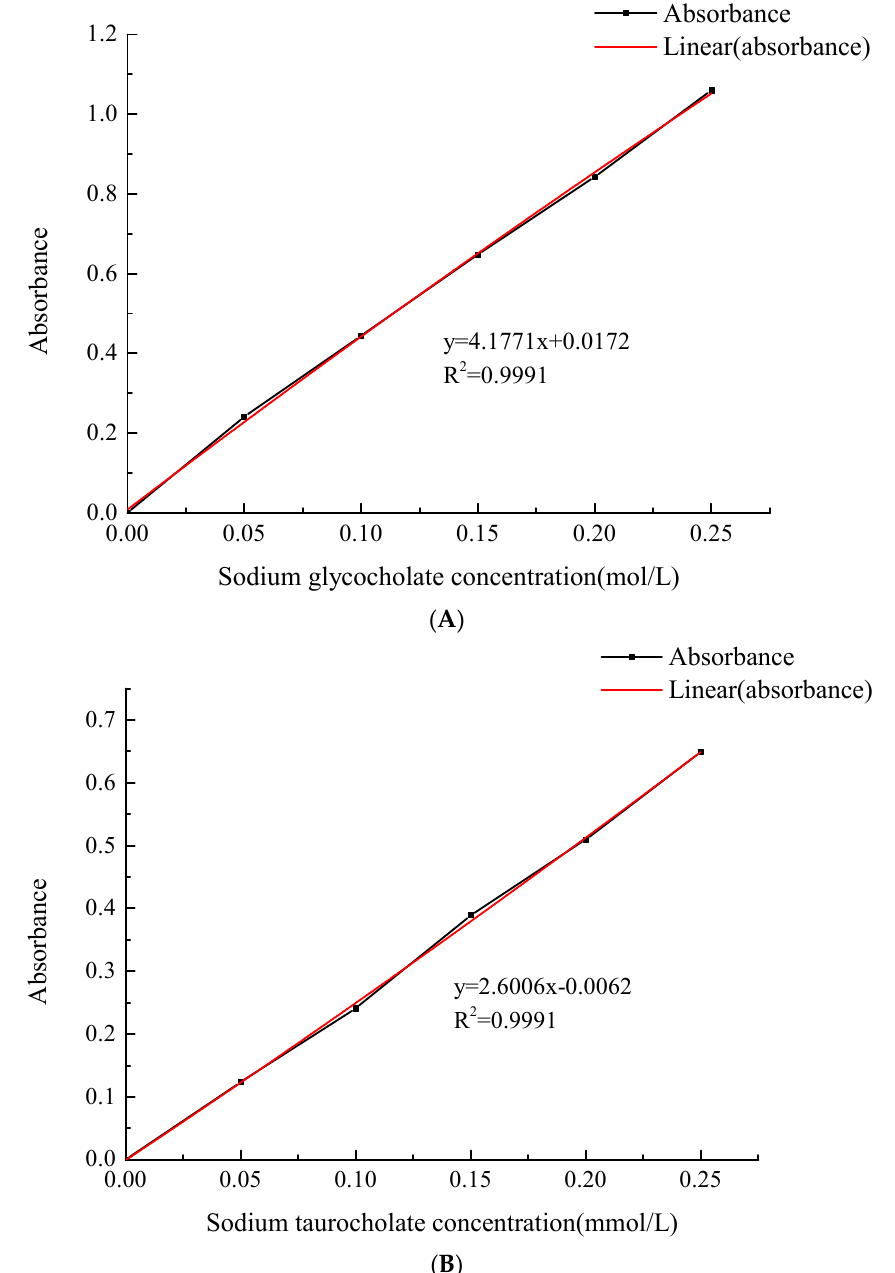
Figure 8. Cholate standard curve. ( A ) Standard curve of sodium glycocholate ; ( B ) Standard curve of sodium taurocholate.